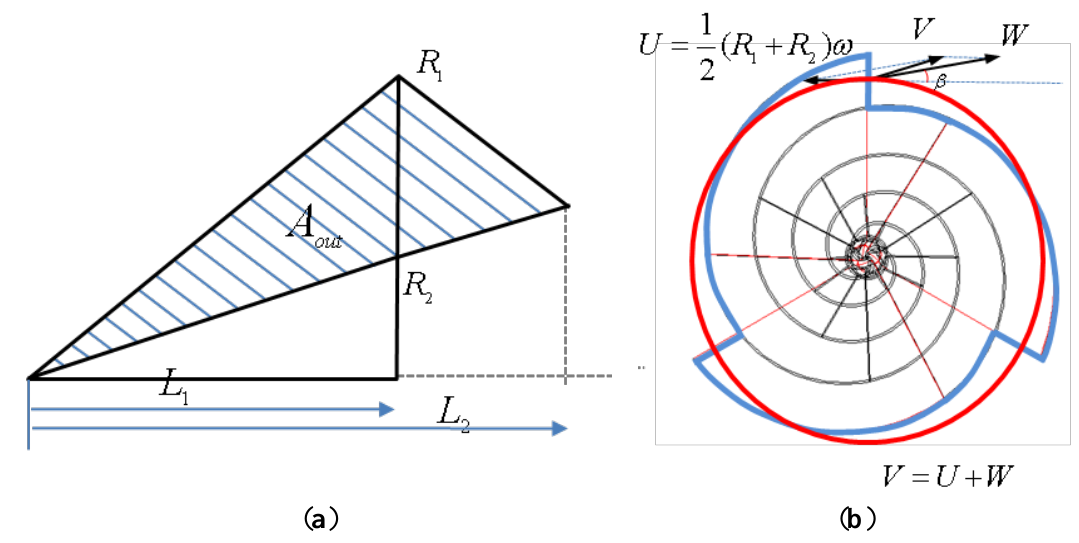
Figure A1. Definition of A out and U , V and W .